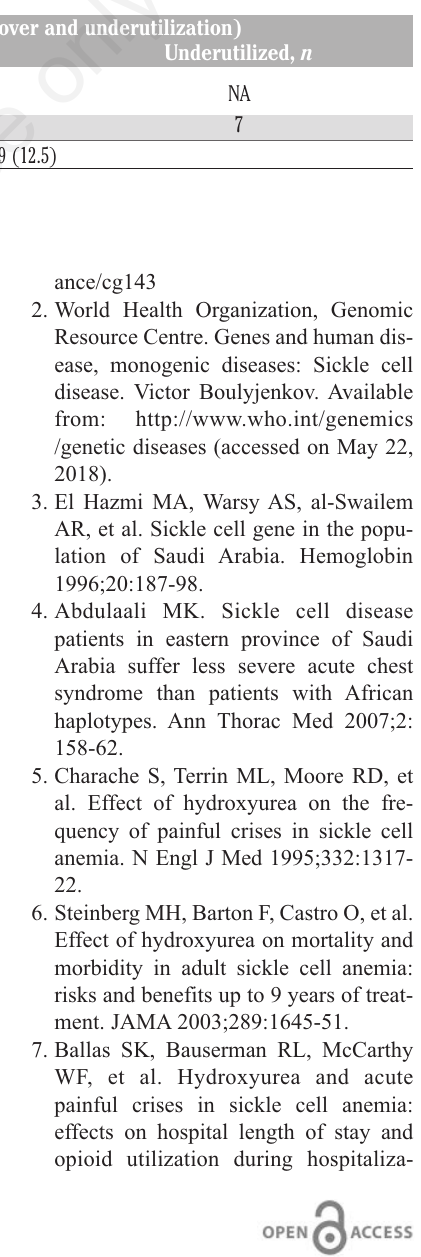
Table 2. Pattern of HU prescription. Appropriate, n Total inappropriate (over and underutilization) Over utilized,